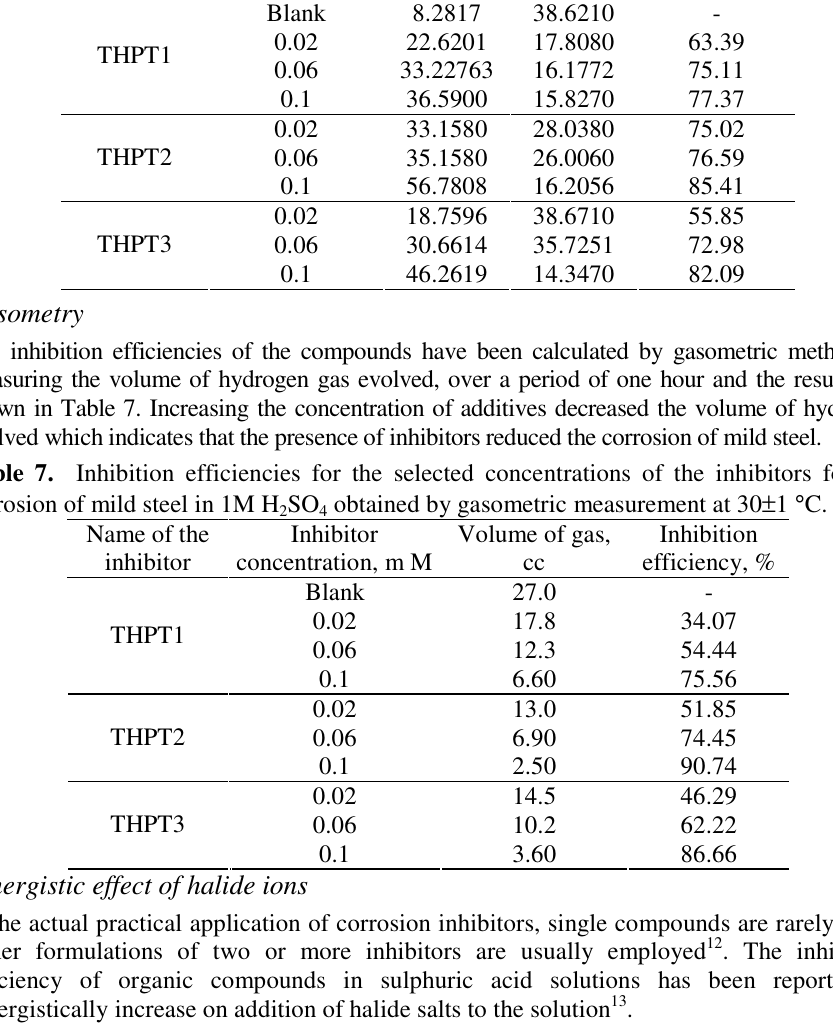
Table 6. AC-impedance parameters for corrosion of mild steel for selected concentrations of the inhibitors in 1 M H